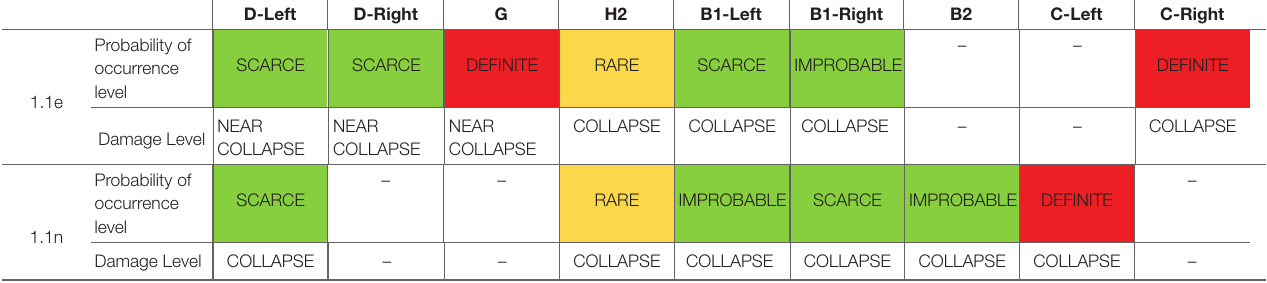
TABLE 3 | Probability of occurrence level and damage levels identified for the POSSIBLE failure modes captured by LOG-IDEAH for the building 1.1. D-Left